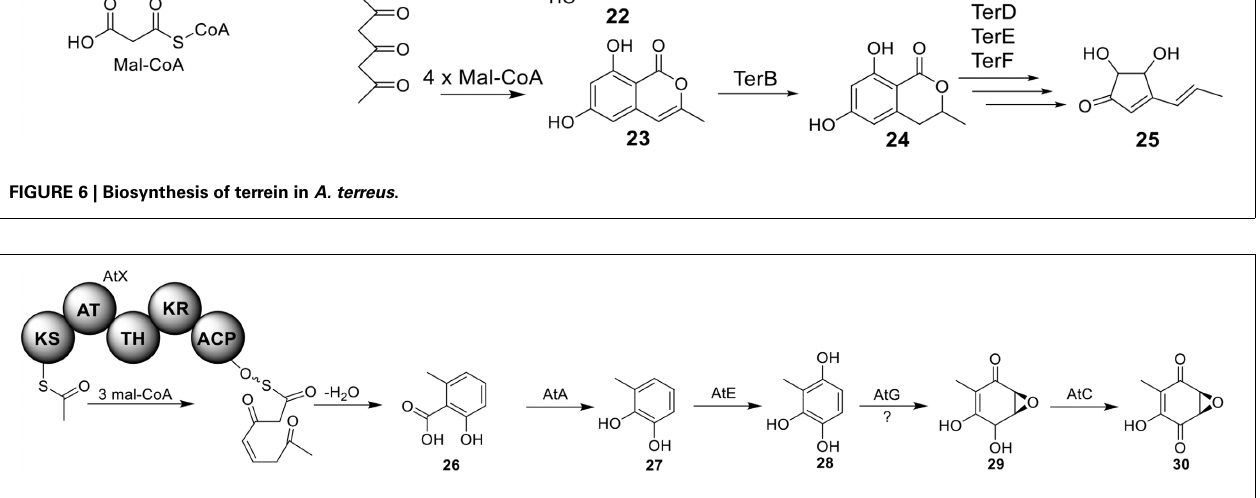
FIGURE 7 | Biosynthesis of terreic acid in A. terreus .